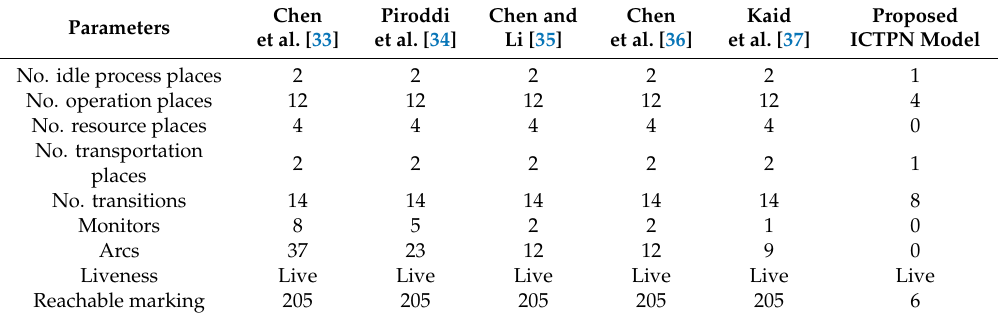
Table 1. Structural complexity comparison with the existing policies.